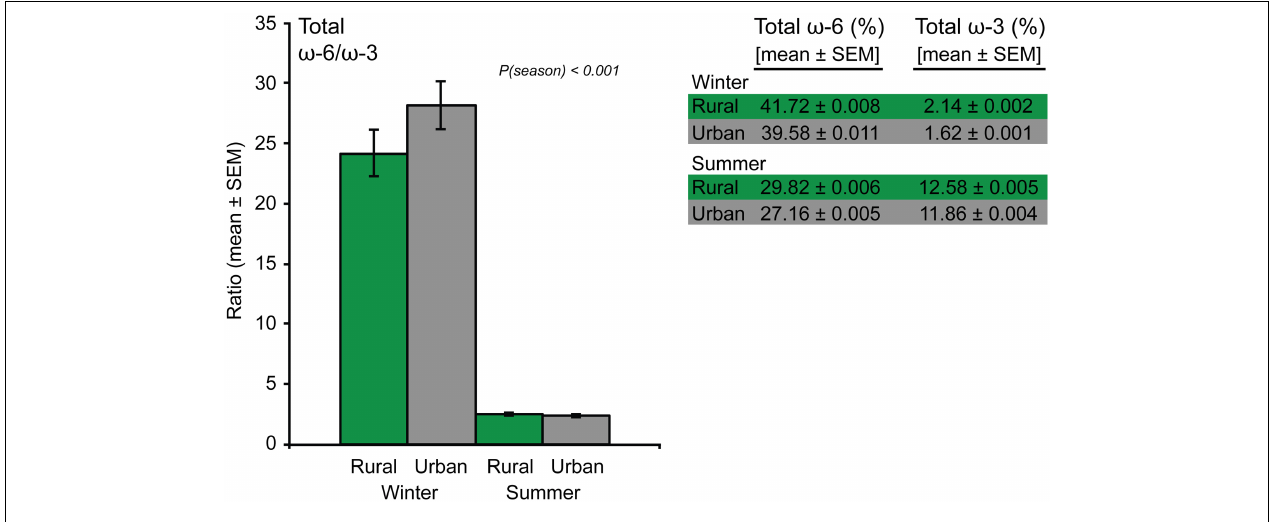
FIGURE 5 | The within-individual ratio between total ω -6 and total ω -3 polyunsaturated fatty acids in blood plasma from urban and rural great tits during winter and summer (left panel). The significant